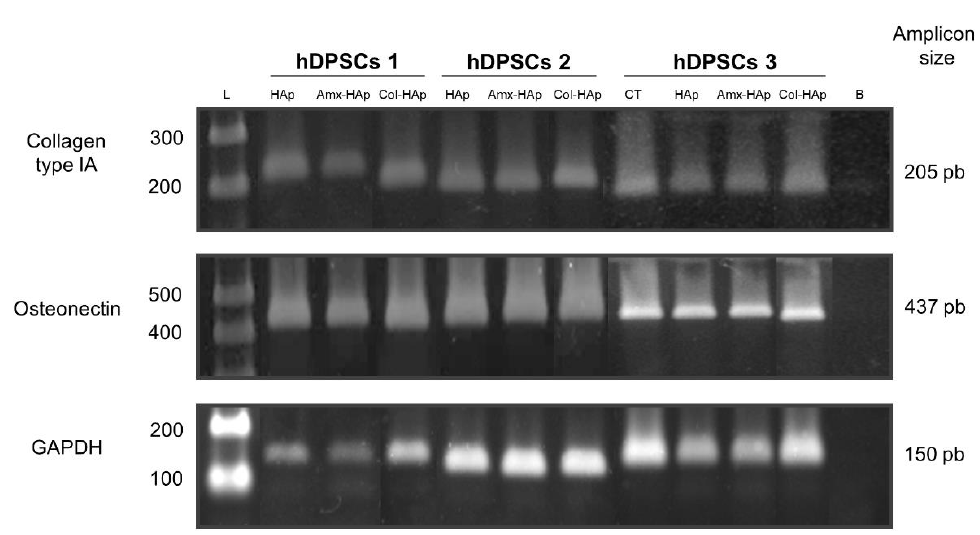
Figure 6. Expression of the collagen type IA and osteonectin markers of osteogenesis by PCR. Com- parison between the control (hDPSCs with no osteogenic induction) and three samples of hDPSCs (submitted to six different mediums of osteogenic induction). CT, control; HAps, hydroxyapatite nanosheet-assembled microspheres; Amx–HAp, amoxicillin–hydroxyapatite composite; Col–Hap, collagen–hydroxyapatite composite; L, ladder; B, blank; GAPDH, glyceraldehyde-3-phosphate de-